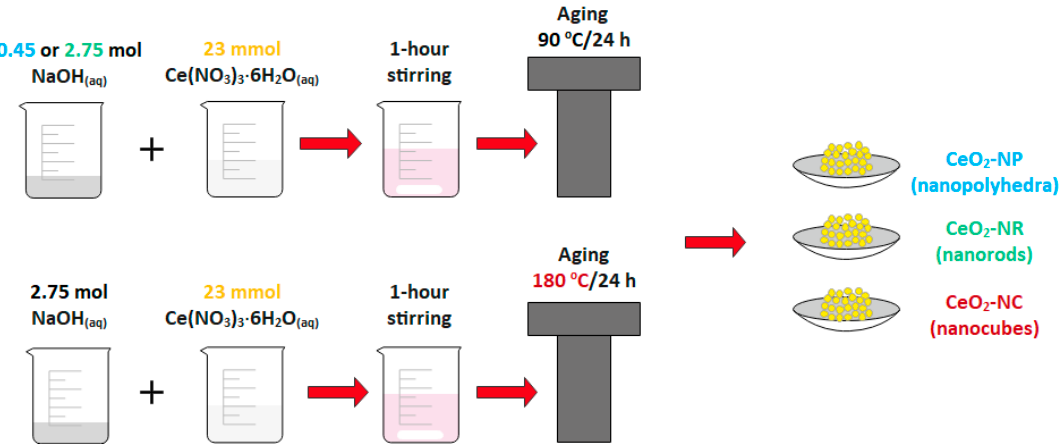
Figure 2. Schematic illustration of synthetic procedure of ceria nanoparticles of different shape (nanocubes = NC, nanorods = NR, and nanopolyhedra = NP).